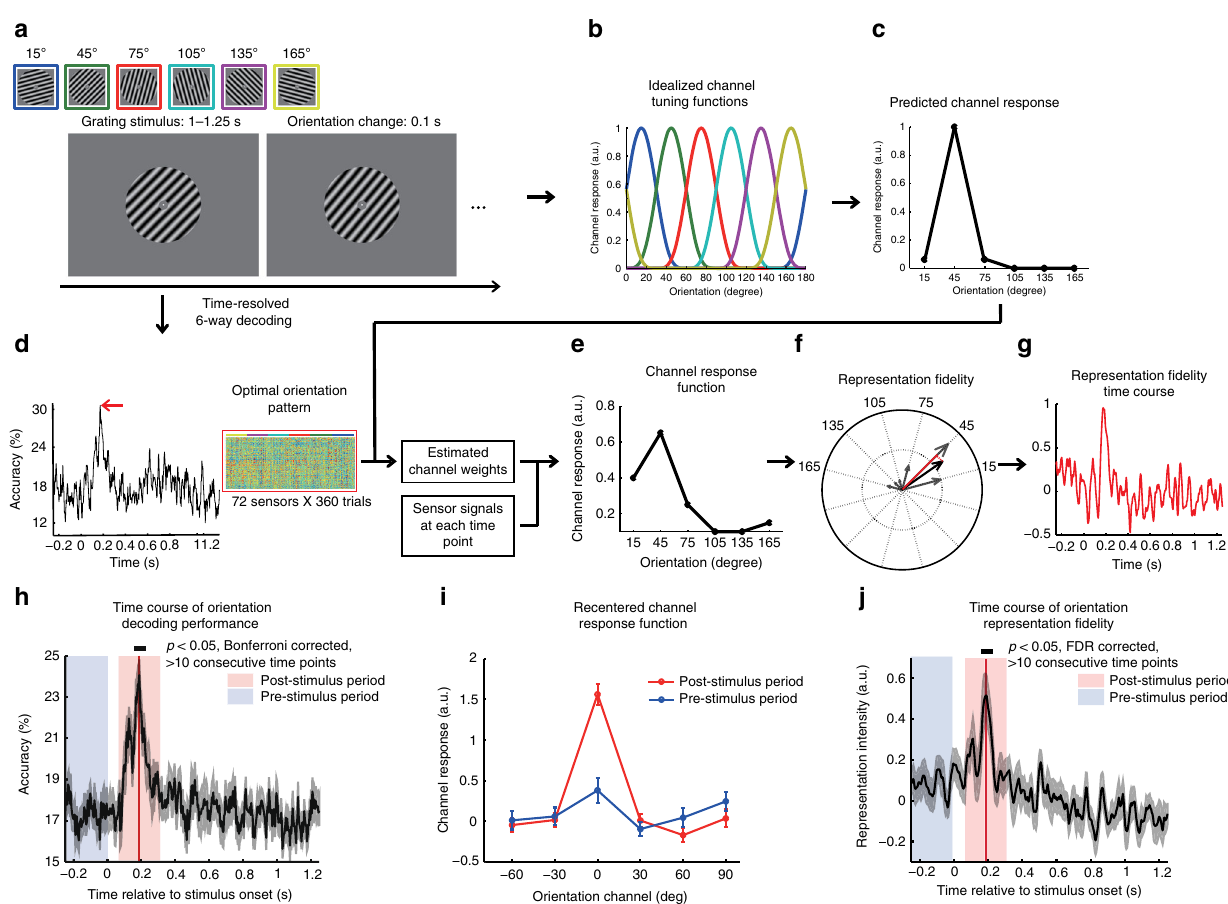
Fig. 1 IEM-based time-resolved reconstruction of orientation representation. a Stimuli and trial structure in the model training part. Subjects performed an orientation discrimination task at one of six orientations (15° – 165° in steps of 30°, coded in different colors) that corresponded to the preferred orientation of six orientation channels. b The idealized tuning of these channels were characterized as smooth, Gaussian-like functions centered at their respective preferred orientation and plotted in the corresponding colors as in a , which spanned the entire orientation space. c Channel responses to a given orientation (e.g., 45°) could thus be predicted based on the functions. d The time-resolved decoding analysis was performed on the model training part data. The pattern of instantaneous MEG sensor signals that achieved the highest decoding accuracy (indicated by the red arrow) was extracted as the optimal orientation pattern (shown inset). Correspondence of trial-wise vectors of sensor signals (organized in columns) to the six orientations was color coded in the top row. The contribution of each orientation channel (i.e., weight) to the MEG signal from each sensor was estimated based on the optimal orientation pattern. These estimated weights were then inverted and applied to each time point to reconstruct the instantaneous channel response function at that time point, as shown in e . f The degree to which the reconstructed channel responses encoded the information of an orientation (e.g., 45°) was quanti fi ed as representation fi delity, which was calculated as the projection of the mean vector onto the direction corresponding to that orientation. g The reconstruction procedure was performed at each time point, yielding a continuous representation fi delity time course. h Time course of orientation decoding performance. i Averaged channel response functions across the six orientations with the reference channel (0°) at their respective peak orientation. Error bars denote one SEM across subjects. j Time course of orientation representation fi delity averaged across the six orientations. The gray-shaded area around the curve denotes one SEM across subjects and the red solid line indicates the time point of the highest decoding performance in h and time period exhibited a fl at pro fi le ( F (5,84) = 0.26, p = 0.93, Supplementary Fig. 2a) with little representation of orientation